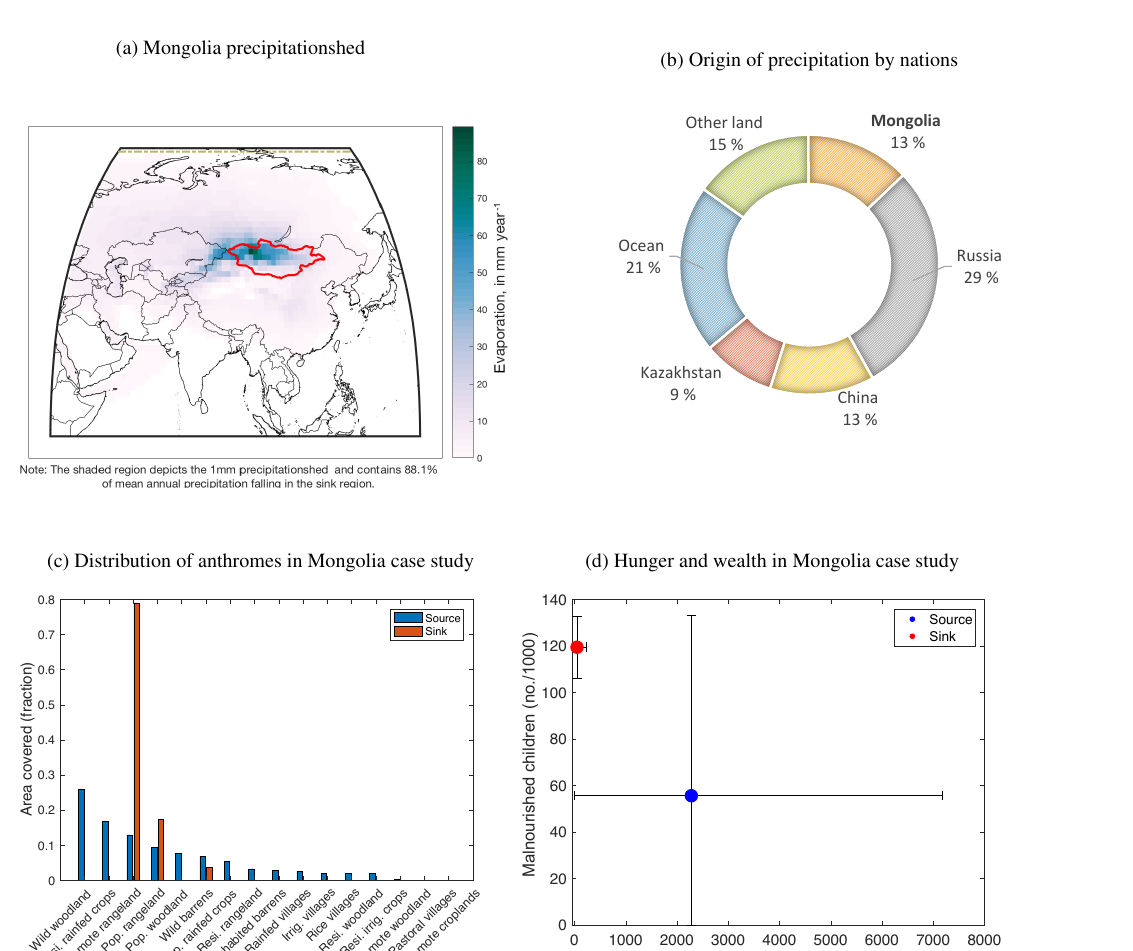
nearly USD 0 to more than USD 11 000. Likewise, the